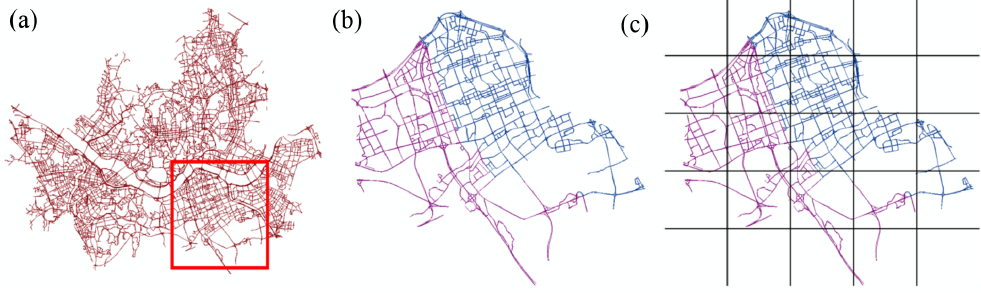
Figure 6. (a) The road network GIS shapefile of Seoul, South Korea. (b) Two districts differentiated using different colors (purple and blue). (c) The modeling grid cells shown over the road